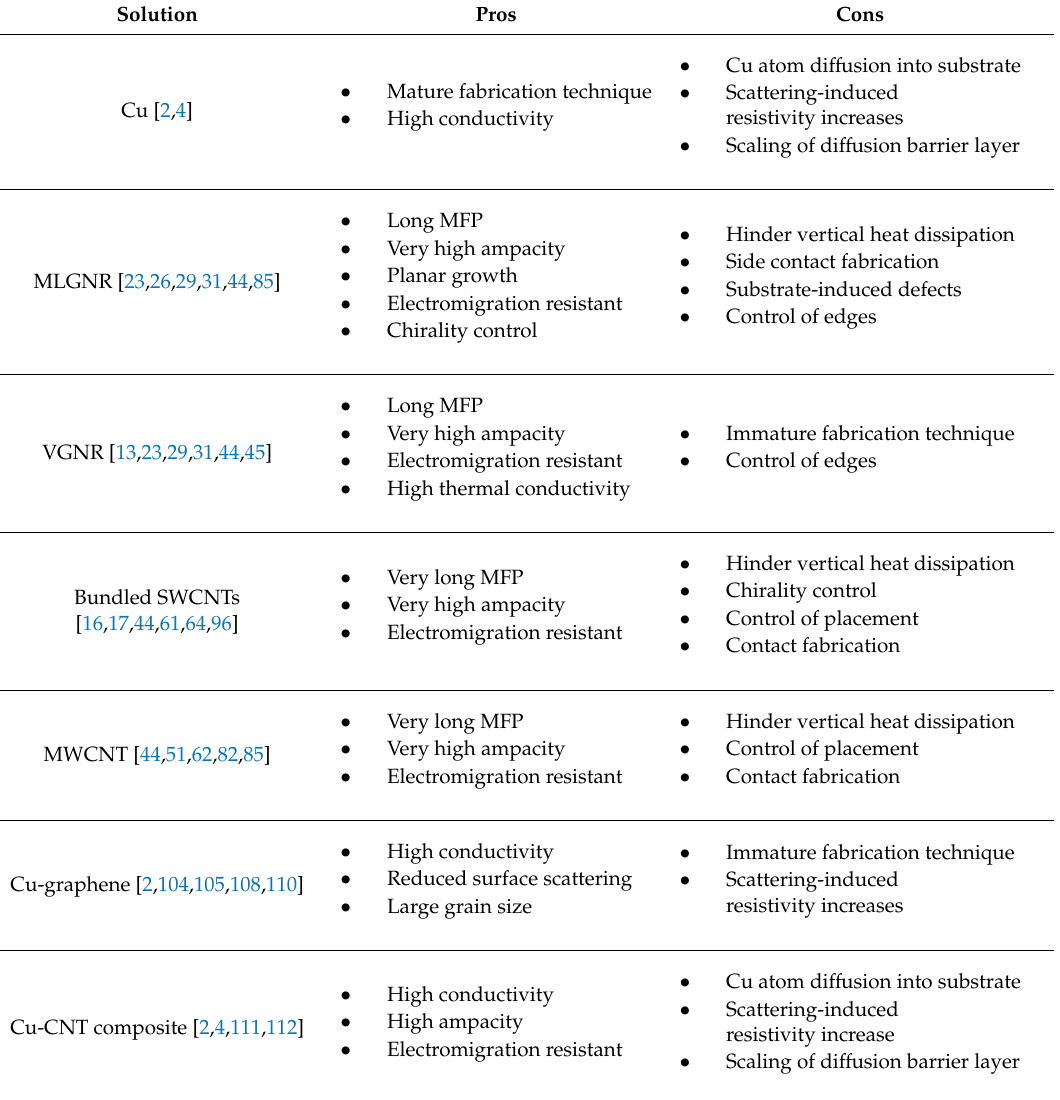
Table 1. Comparison of Cu, GNR, CNT, Cu-graphene, and Cu-CNT